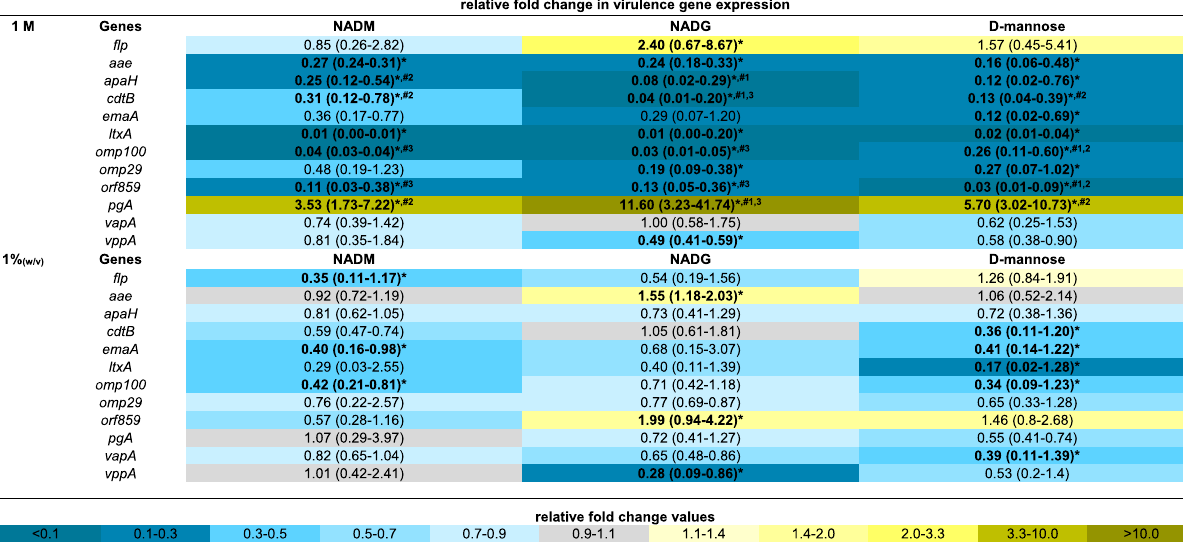
Table 1. Comparison of the effects of repeated multi-species biofilm rinsing with NADM, NADG or d-(+)- mannose on A. actinomycetemcomitans virulence gene expression. Fold changes in virulence gene expression were determined relative to the control condition through the 2 −ΔΔCt method and are shown as the geometric mean (C.I.) (n = 3) of the 2 −ΔΔCt values. All substrates were dissolved in PBS at 1 M (upper part) or ~ 0.05 M (1% (w/v) ) (lower part) (0.045 M (NADM and NADG) and 0.056 M (d-(+)-mannose)). Values between 0 and 1 represent relative downregulation, values > 1 relative upregulation. Statistically significantly values relative to the control (PBS) that are < 0.5 (> twofold downregulated) or > 1.5 (> 1.5-fold upregulated) are considered biologically relevant and shown in bold and marked with ‘ * ’ ( P < 0.05, ANOVA + Dunnett’s correction